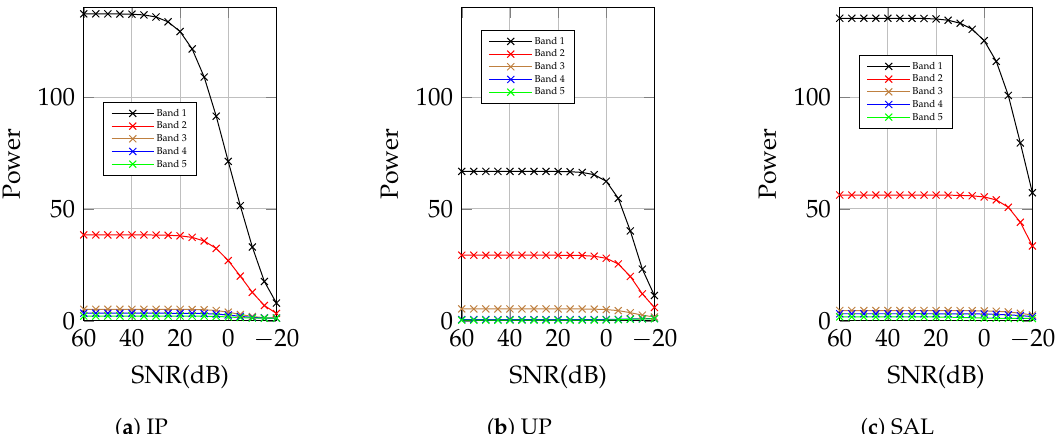
Figure 9. First five tensorial bands power from G , after performing TKD from 60 dB to − 20 dB, α = 1.